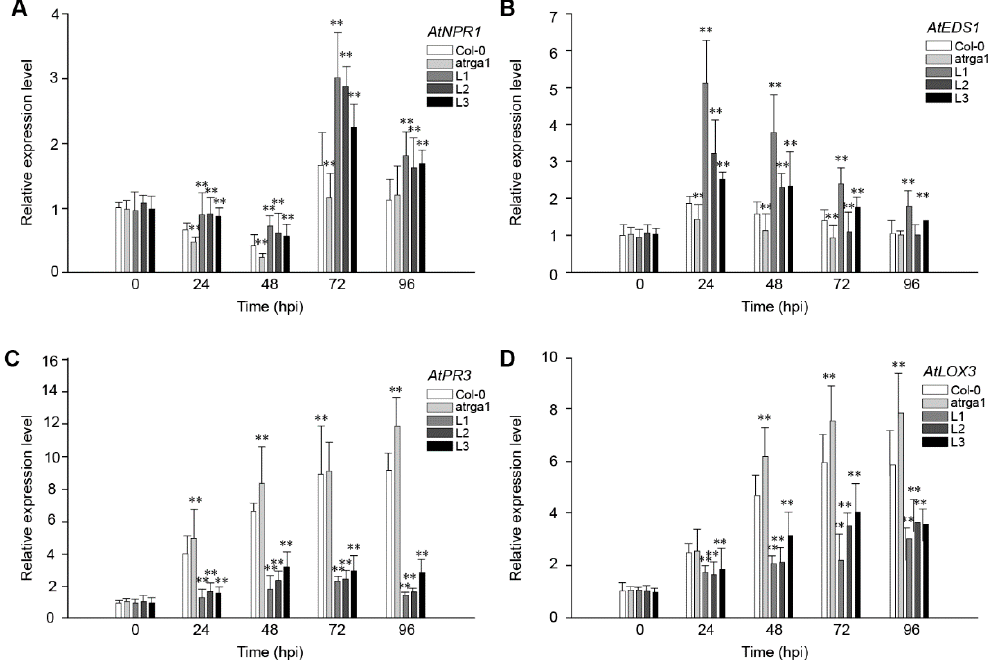
Figure 8. Assessment of the expression of defense-related genes at different time points after inoculating B. cinerea. Relative expression levels of ( A ) AtNPR1; ( B ) AtEDS1 ; ( C ) AtPR3 , and ( D ) LOX3 were detected via qRT-PCR . Data represent mean values ± SD from three independent experiments. Asterisks show the statistically significant difference (** p < 0.01, Student’s t test).